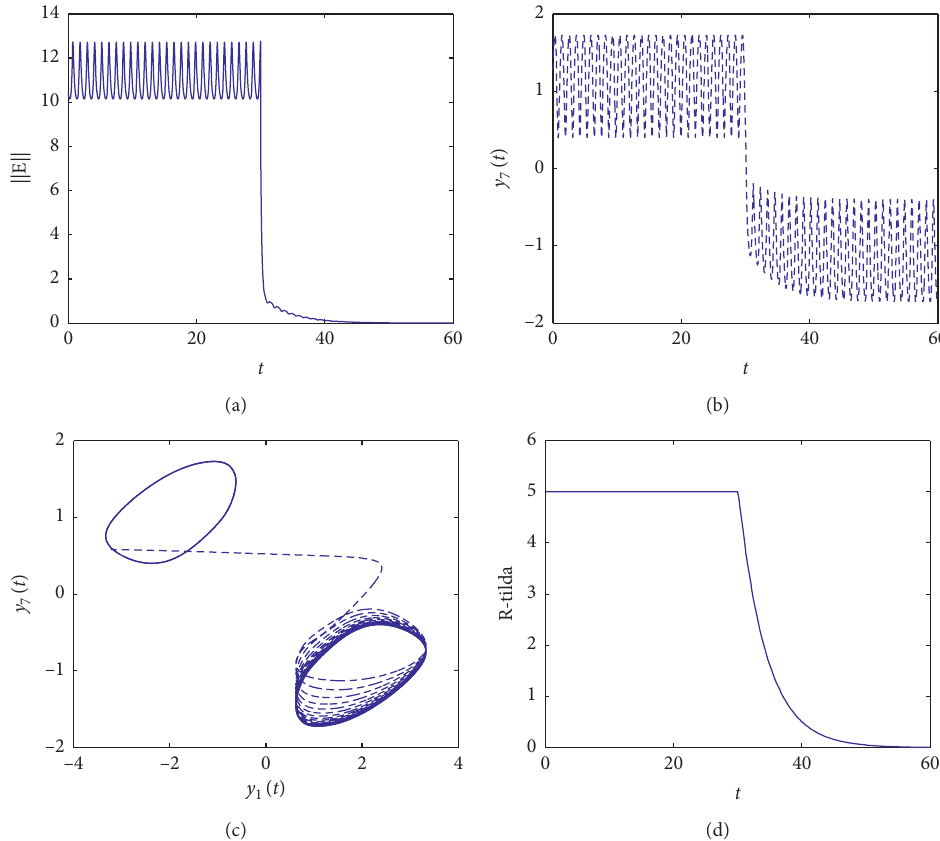
Figure 7: Adaptive control of the periodic regime of the slave system at R number. The controller is switched on at time t � 30. (a) The L time. (c) The phase portrait of the states of the slave system y